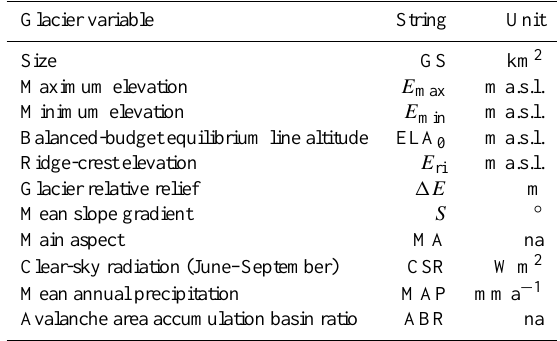
Table 1. Glacier variables considered. Glacier